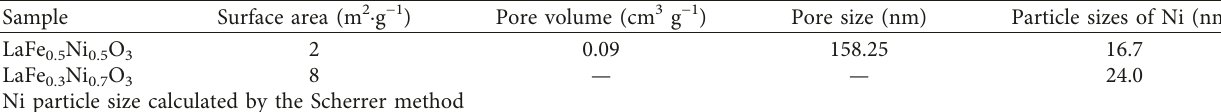
Table 3: Textural properties of the catalysts after stability test.